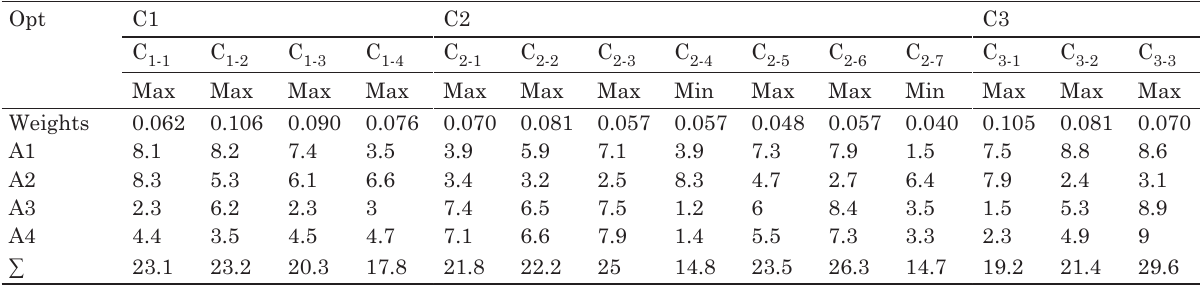
Table 8. Initial decision-making matrix with values of the attributes describing the compared alternatives (COPRAS)